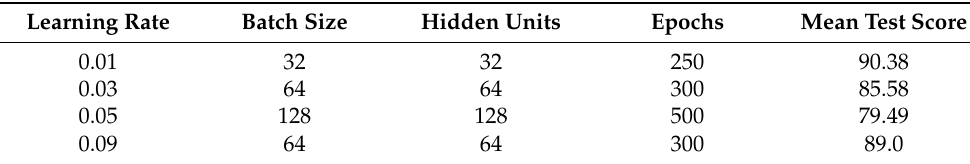
Table 7. Optimized Hyper parameters.